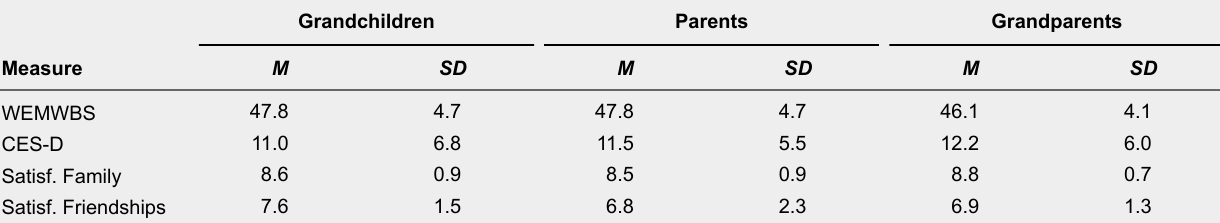
Mean (i.e., M) Scores Relative to the Warwick-Edinburgh Mental Well-Being Scale (i.e., WEMWBS), Depressive Signs (i.e., CES-D), After Controlling for Perceived Satisfaction About Family (i.e., Satisf. Family), and Perceived Satisfaction About Nonfamily (i.e., Satisf. Friendships)